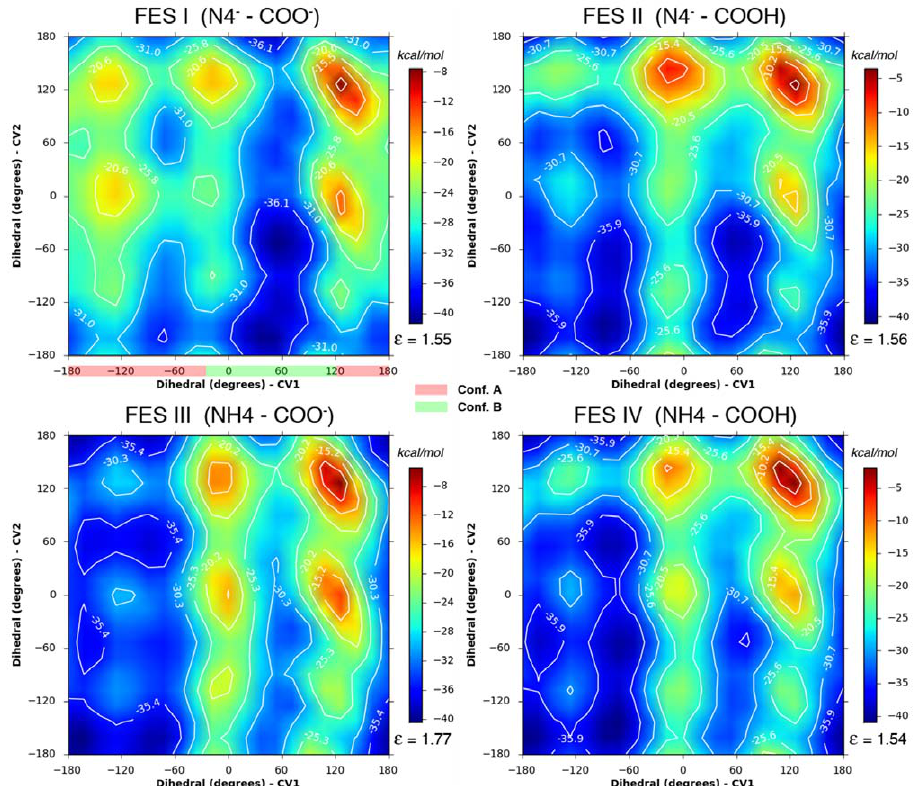
Figure 8. Free energy surfaces (FESs) of the hydroxyethyl group rotations in solution. FESs were calculated under four conditions corresponding to 1) deprotonated N4 and C6 carboxylate (FES I), 2) deprotonated N4 and protonated C6 carboxylate (FES II), 3) protonated N4 and deprotonated C6 carboxylate (FES III), 4) protonated N4 and C6 carboxylate (FES IV). The collective variables (CV) sampled in the metadynamics simulations were the dihedral angle defined by atoms N4-C5-C6-C61 (see Fig. 2) or ‘‘Dihedral CV1’’, and the dihedral angle defined by atoms C5-C6- C61-O62 or ‘‘Dihedral CV2’’. The ranges of Dihedral 1 values corresponding to Conformation A and Conformation B are highlighted in red and green, respectively, in the FES I panel. The start point for all simulations was conformation B. The average error e (kcal/mol) of the FES, as calculated from equation (4) (see Methods) is shown in each panel below the color bar.